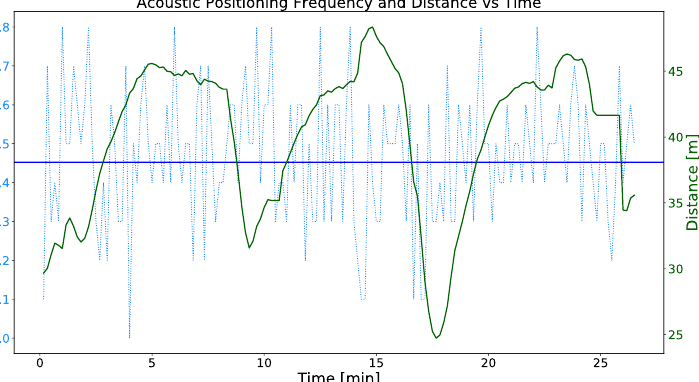
Figure 17. The green line represents the time evolution of the distance between the ASV and the AUV while the latter performs the test bench mission template and the ASV runs the tracking coordination strategy. The blue dotted line represents the frequency of the acoustic positioning corrections. Finally, the blue line represents the mean of the acoustic positioning reception frequencies. The sample mean value of the acoustic positioning frequency is 0.468 Hz.